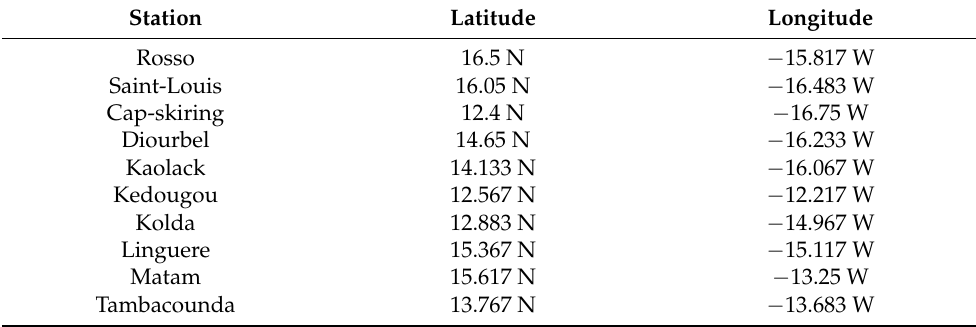
Table 1. Summary of Latitude and Longitude of selected locations.